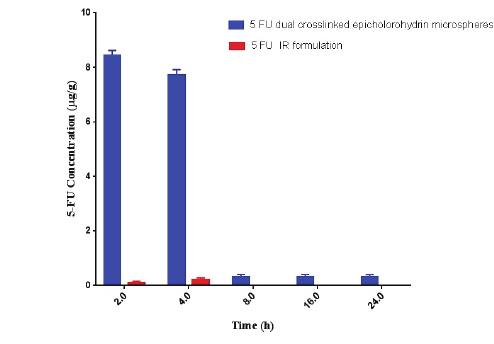
Figure 3: Drug concentration versus time profiles of encapsulated and free 5-FU in: (A) plasma; (B) stomach tissue homogenate; and (C) intestinal tissue homogenate after oral administration of colon- specific microspheres in Wistar rats. The immediate release (IR) formulation of 5-FU was prepared by suspending the drug in 0.5% w/v sodium carboxymethylcellulose. Data are mean± s.d.